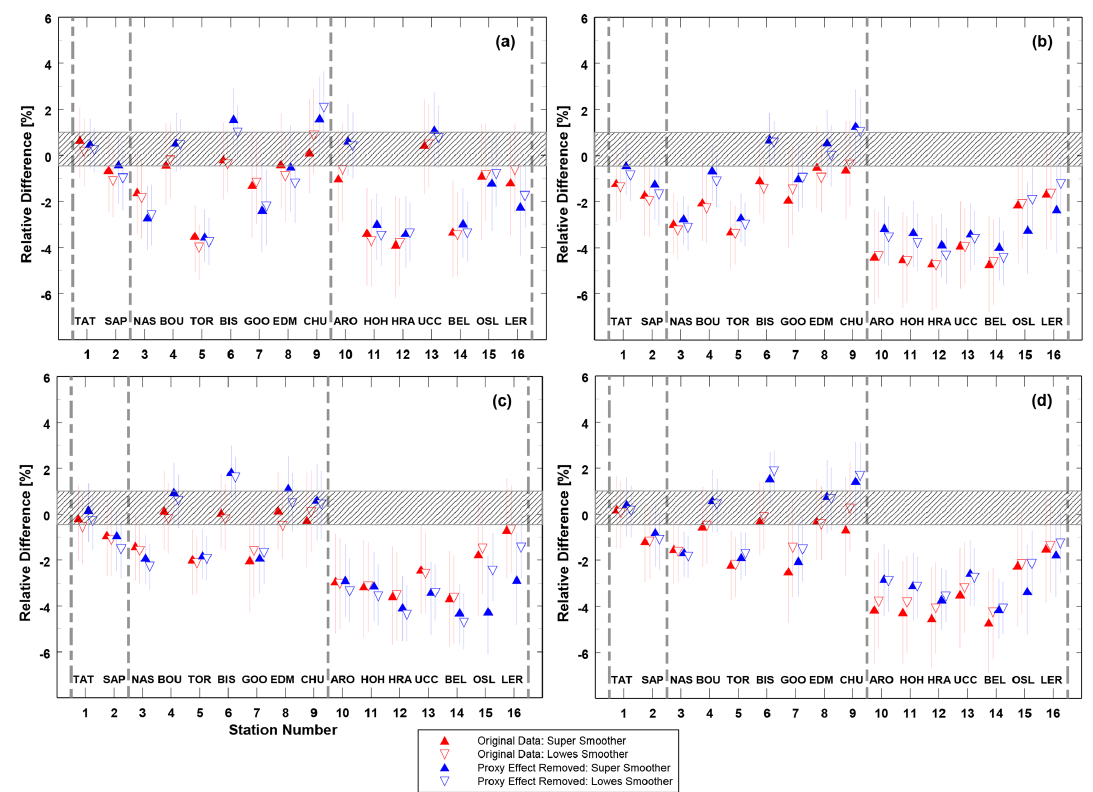
Figure 4. Median of the ozone recovery index, ORI 1 (1988, 2020) estimate (triangle) based on Eq. (1) and its uncertainty range (line) for 16 NH mid-latitudinal stations (Table 1) and various combinations of data smoothers and datasets: WOUDC data (a) , MOD data (b) , MSR2 (c) , and MERRA2 (d) . Results in red are for the original data and in blue for the data with removed natural variability. The hatched area marks the reference range, − 0 . 5% to 1.0%, calculated in Sect.